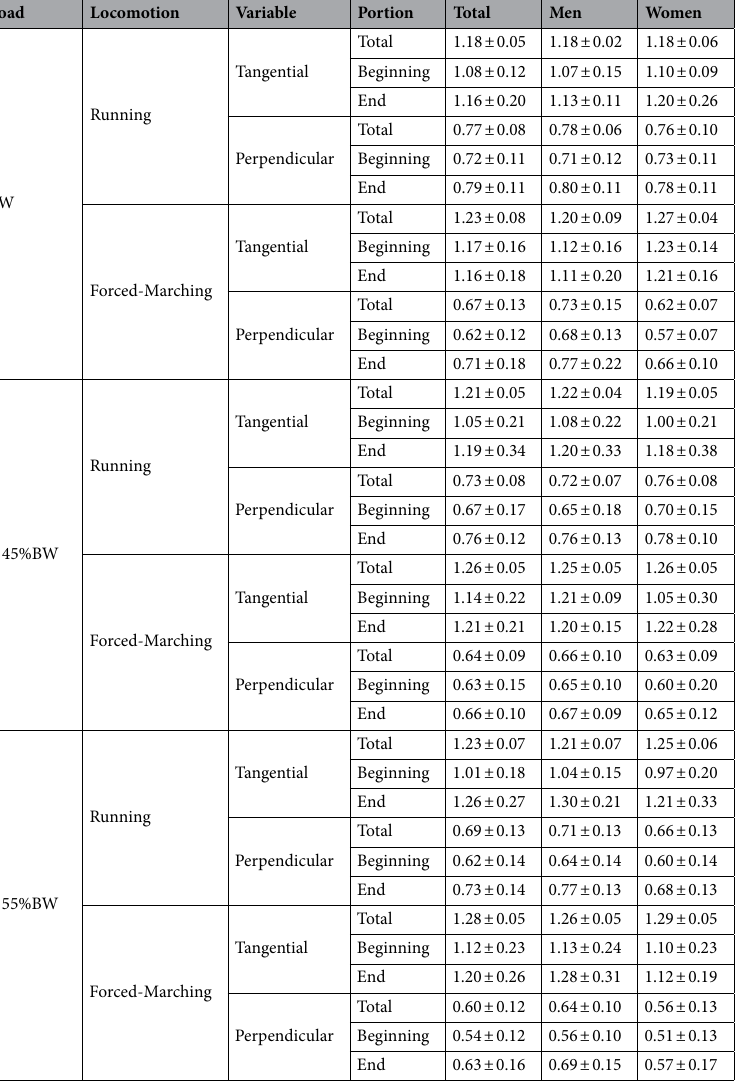
Table 4. Subspace variability. mean ± standard deviation. Tangential represents ‘null space’ variability; Perpendicular represents ‘task space’